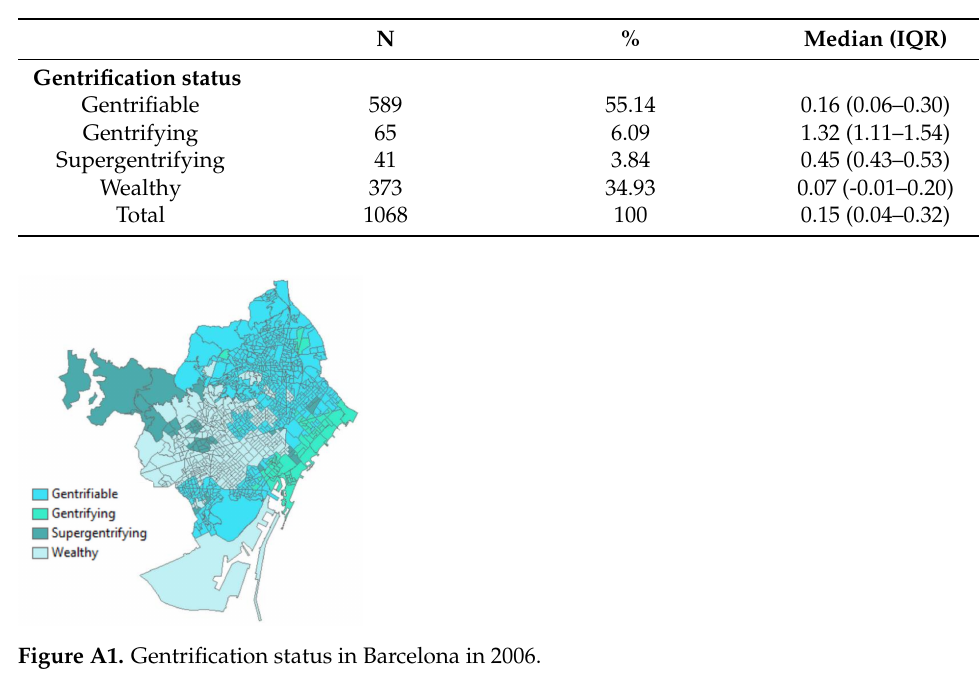
Table A1. Distribution of census tracts by gentrification status (absolute and relative frequencies) and Median (interquartile range, IQR) gentrification score for each category.